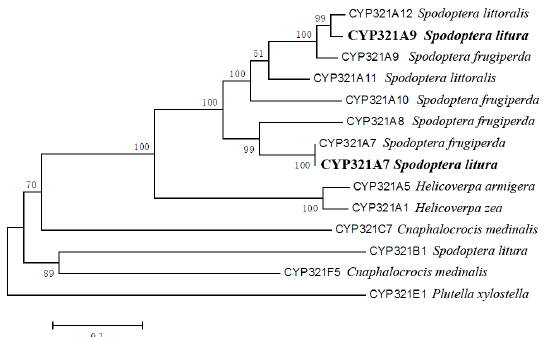
Figure 1. Phylogenetic analysis of CYP321A7 and CYP321A9 of Spodoptera litura and related P450s. The phylogenetic tree was constructed with MEGA 6.0 software (Neighbour-joining method). The scale bar indicates 0.1 amino acid substitutions per site. Bootstrap analysis was performed with 1000 replications.